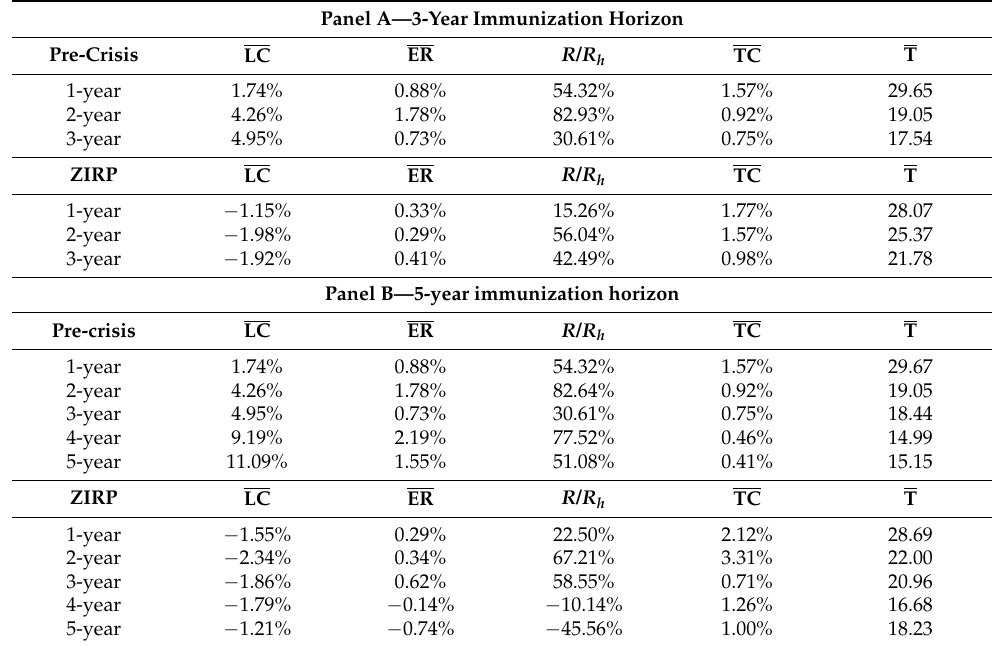
Table 4. U.S. Treasuries Sensitivity Analysis Immunization Results.